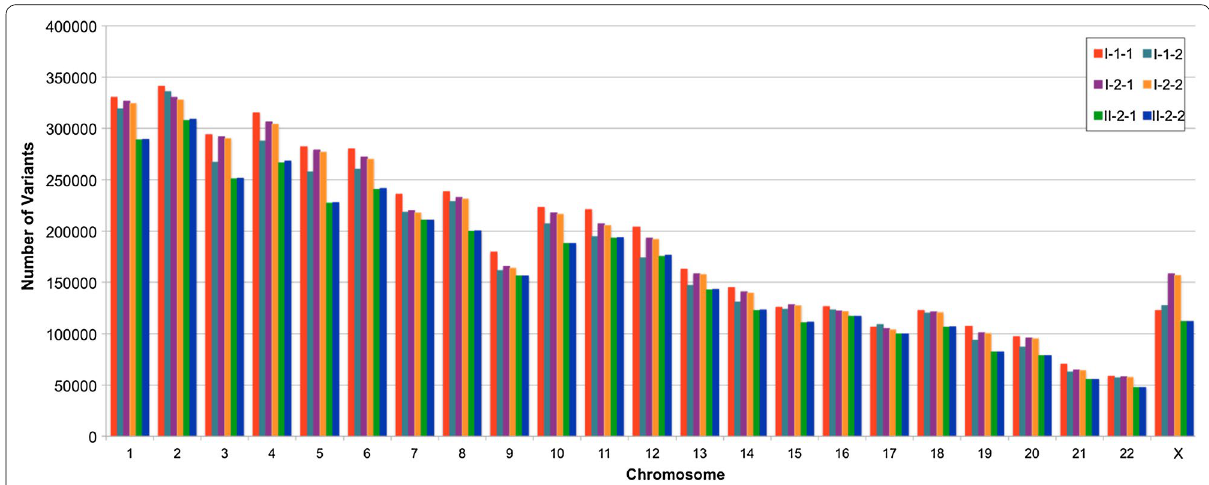
Fig. 3 Chromosomal distribution of small sequence variations (SNVs, Indels, block substitutions) in all six samples